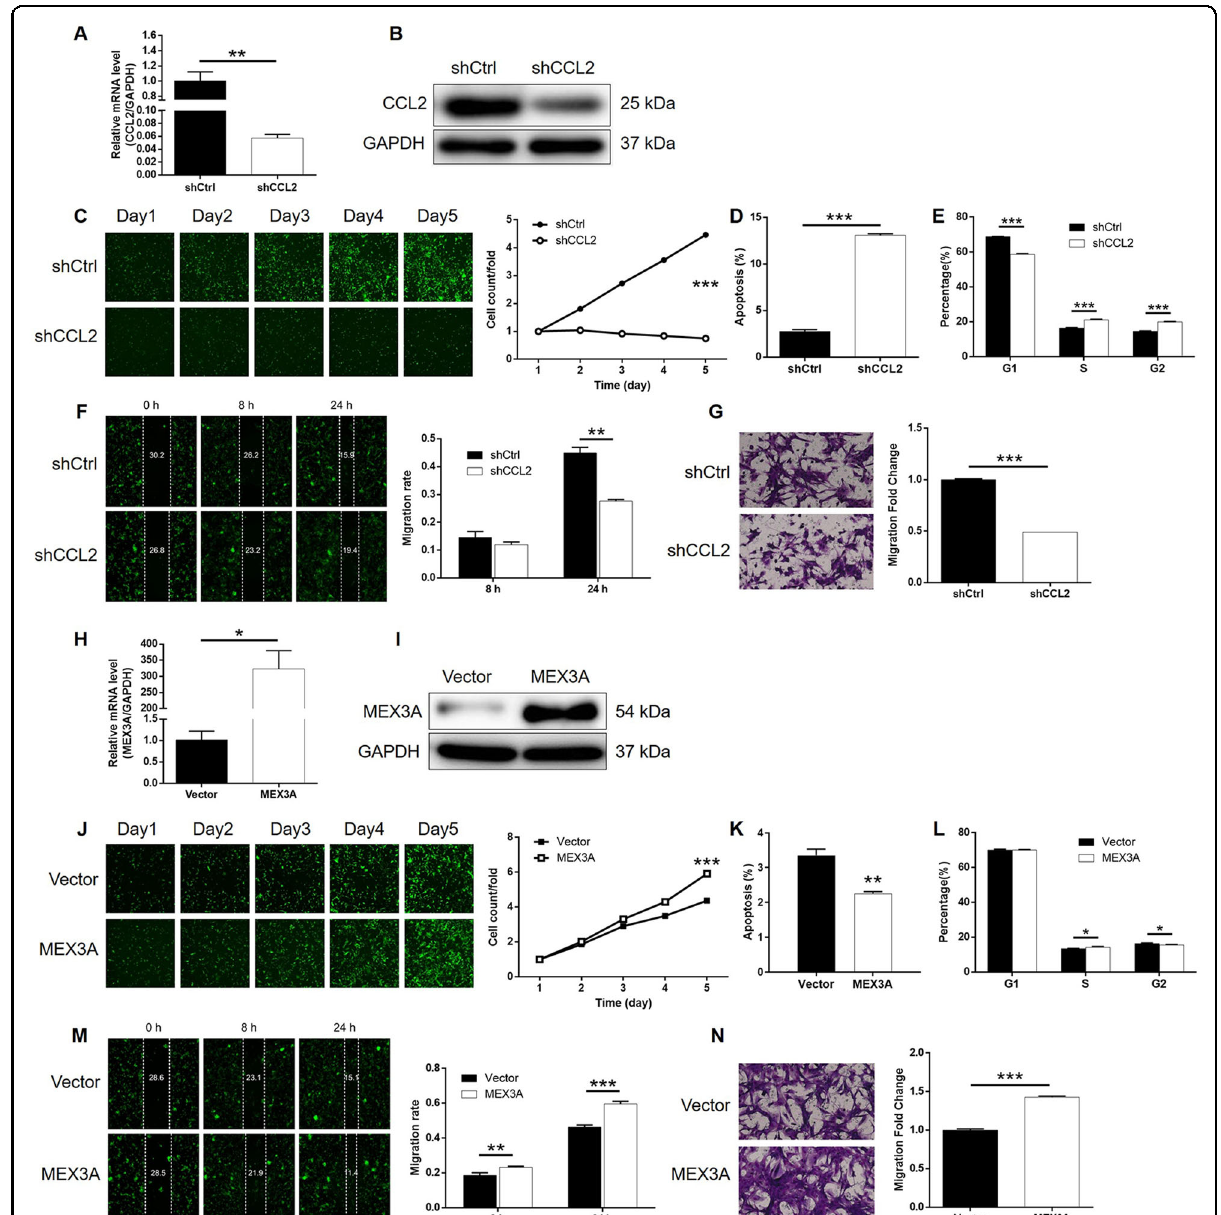
Fig. 5 CCL2 knockdown inhibited glioma development, MEX3A overexpression promoted glioma development in vitro. A , B Cell models with or without CCL2 knockdown were constructed by transfecting shCCL2 or shCtrl. The knockdown ef fi ciency of CCL2 in U251 cells was assessed by qPCR ( A ) and western blotting ( B ). C Celigo cell counting assay was employed to show the effects of CCL2 on cell proliferation of U251 cells. Flow cytometry was performed to detect cell apoptosis ( D ) and cell cycle distribution ( E ) of U251 cells with or without CCL2 knockdown. F , G The effects of CCL2 on the cell migration ability of U251 cells were evaluated by wound-healing assay ( F ) and Transwell assay ( G ). H , I Cell models with or without MEX3A overexpression were constructed by transfecting control or MEX3A-overexpression plasmids. The overexpression ef fi ciency of MEX3A in U251 cells was assessed by qPCR ( H ) and western blotting ( I ). J Celigo cell counting assay was employed to show the effects of MEX3A on cell proliferation of U251 cells. Flow cytometry was performed to detect cell apoptosis ( K ) and cell cycle distribution ( L ) of U251 cells with or without MEX3A overexpression. M , N The effects of MEX3A on the cell migration ability of U251 cells were evaluated by wound-healing assay ( M ) and Transwell assay ( N ). The representative images were selected from at least three independent experiments. Data were shown as mean ± SD. * P < 0.05, ** P < 0.01, *** P <